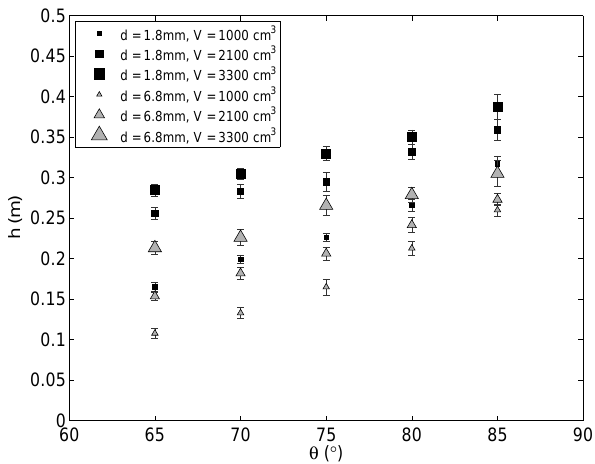
Fig. 10. Average wavelength ( λ ) 1m from the line release versus slope angle ( θ ). Error bars have length equal to the standard devia- tion from the mean. Results are offset horizontally for